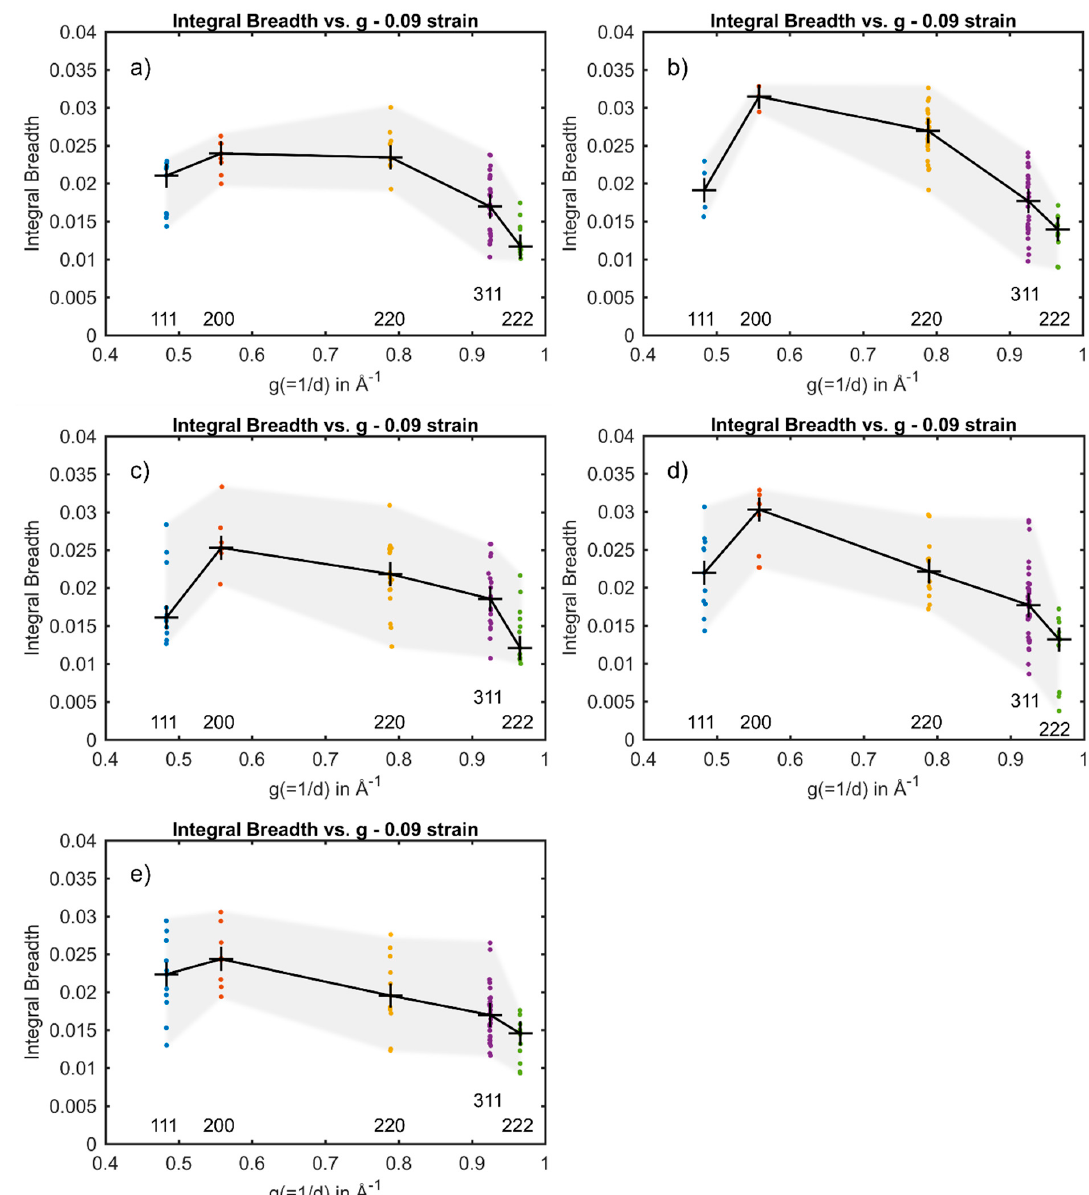
Figure 5. Integral breadth as a function of 𝑔 at 0.09 nominal strain for ( a ) grain #19, ( b ) #26, ( c ) #27, ( d ) #12 and ( e ) #17. From Figure 3, it can be seen that austenite grains deformed along the [100] are found to form stacking faults, whereas in grains oriented with [111] along the tensile direction, the formation of stacking faults is impeded, and the formation of perfect dislocations is dominant. This was studied by investigating the anisotropic broadening of the diffraction peaks as a function of 𝑔 at 0.09 nominal strain. Individual grains at 0.09 nominal strain oriented with [100] along the loading direction, #29, #19, #26 and #27 in Figure 4d and Figure 5a–c, respectively, show the same anisotropic broadening effect in the integral breadth plotted versus the magnitude of 𝒈 leading to a “hook shape” . Besides the shape of the anisotropy, the experimentally determined 𝛼 for grains #29, #19, #26 and #27 with values of 1.17 × 10 (cid:2879)(cid:2871) , 0.86 (cid:3400) 10 (cid:2879)(cid:2871) , 1.29 × 10 (cid:2879)(cid:2871) and 0.96 (cid:3400) 10 (cid:2879)(cid:2871) , respectively, also suggests the presence of significant amounts of stacking faults. In contrast, the integral breadth of the component reflections of the {220} from grain #12 and grain #17 oriented